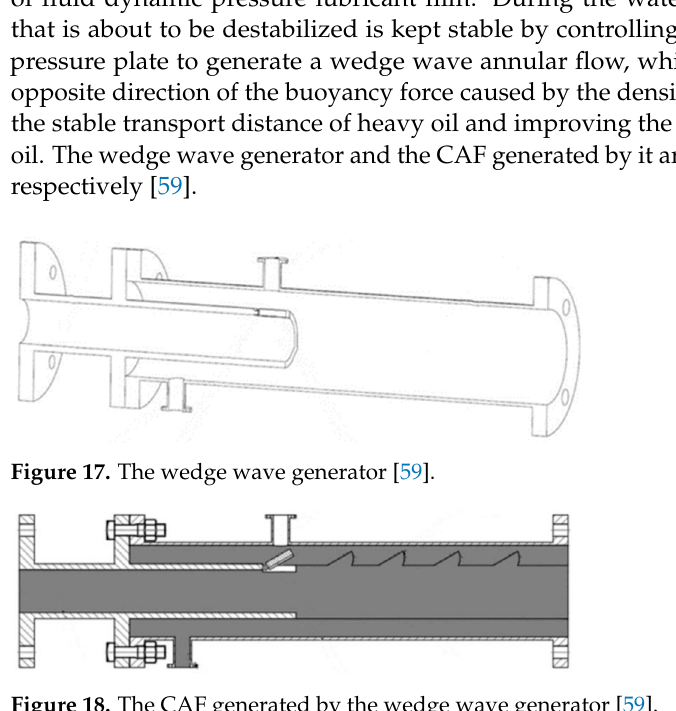
Figure 18. The CAF generated by the wedge wave generator [59].